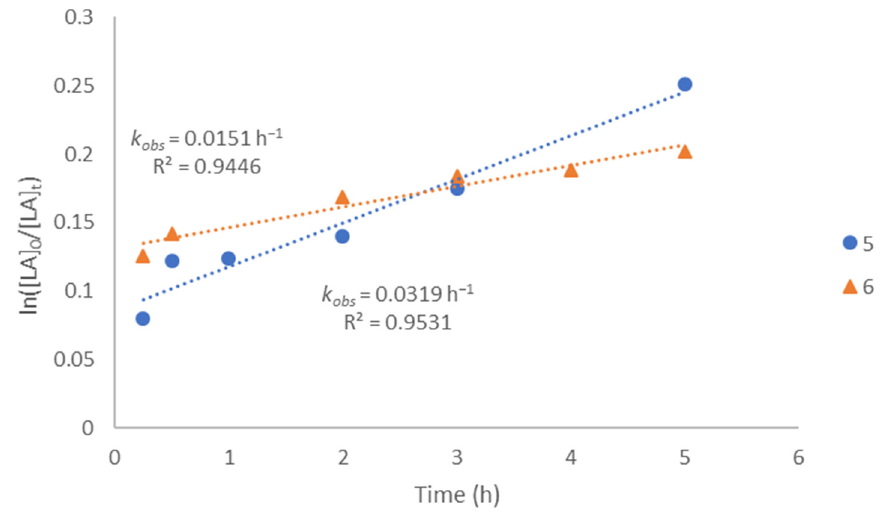
Figure 8. Kinetic plot for ROP of rac -lactide using complexes 5 and 6 . Conditions: 100[LA]:[M], [LA] = 1 mol/L, BnOH = 2 μ L, 130 °C.